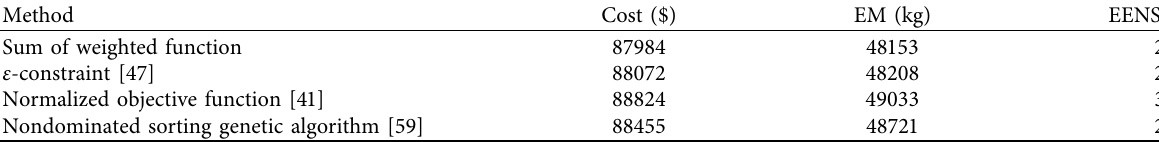
Table 4: The best compromise solution of the proposed scheme.